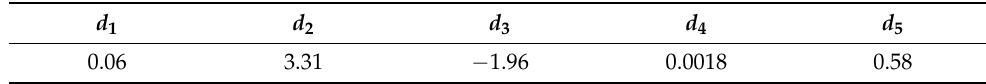
Table 2. Damage parameters of AISI 1045 J–C (unit-less)